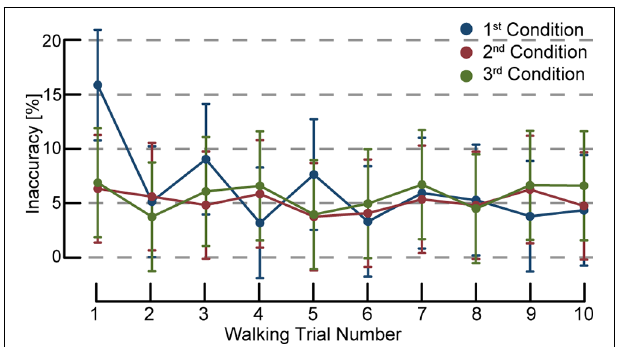
FIGURE 2 | Walking speed inaccuracy percentage by trial number. The first condition using visual feedback is indicated in blue, the second tested condition in red, and third tested condition in green. Error bars denote 95% confidence intervals. The first overall trial regardless of speed condition had a larger percent inaccuracy compared with nearly all subsequent walking trials. The within-trial inaccuracy was 10.5% higher (CI95: 7.4, 13.5) in first trial of the first speed condition compared to subsequent trials. We found no significant differences in walking speed inaccuracy between the second and 10th trial of the first speed condition, or the 1st and 10th trial in the subsequent speed conditions. As the first trial overall appears to be an outlier due to a learning effect, we excluded that trial for the subsequent